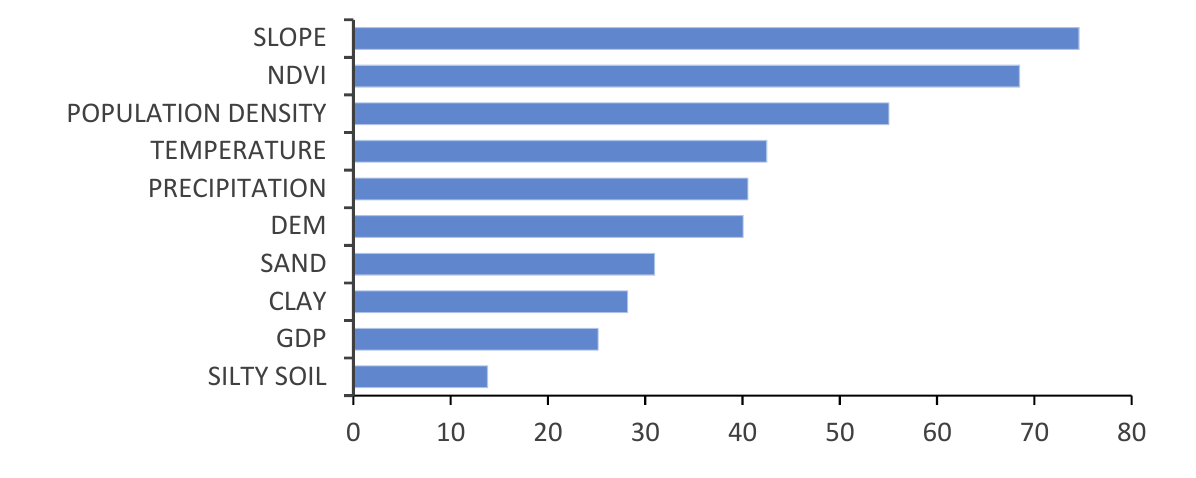
Table 2. Types of